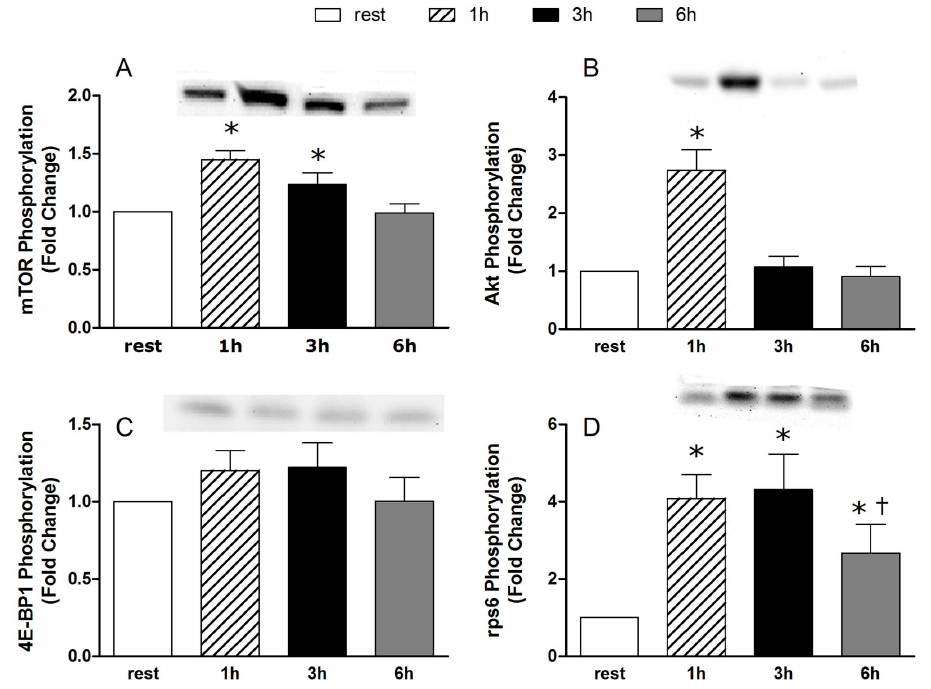
Figure 3. Relationship between muscle hypertrophy and potential correlates. A) The relationship between changes in muscle volume as measured by MRI and the Myofibrillar fractional synthetic rate (FSR) measured from 1 to 6 hours after an acute bout of resistance exercise and nutrition before the start of the resistance training period (r=0.10, P=0.67). B) The relationship between changes in muscle volume as measured by MRI and 4E-BP1 phosphorylation at Thr37/46 measured 1 hour after an acute bout of resistance exercise and nutrition before the start of the resistance training period (r=0.42, P=0.05).